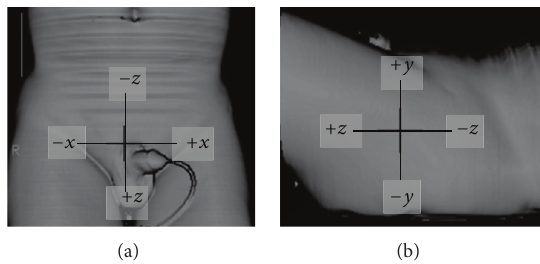
Figure 10: Coordinate system for calculating Δ𝑥, Δ𝑦 , and Δ𝑧 .